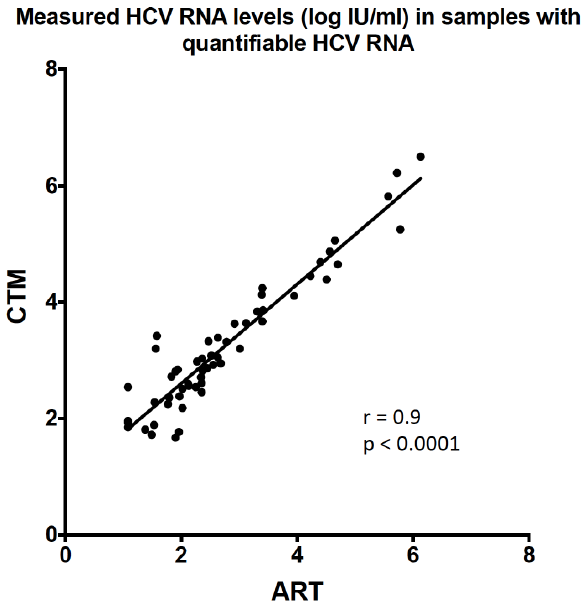
Figure 2. Correlation between the CTM and the ART in samples with quantifiable HCV RNA levels. r: Spearman correlation; p: p- value.